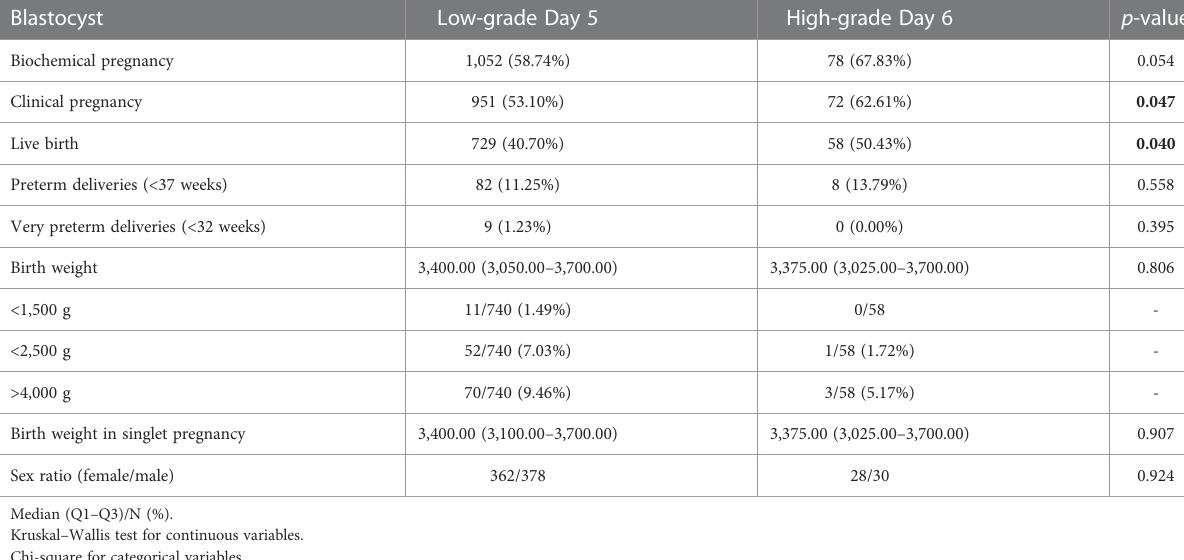
TABLE 2 Perinatal outcomes according to blastocyst day and morphology